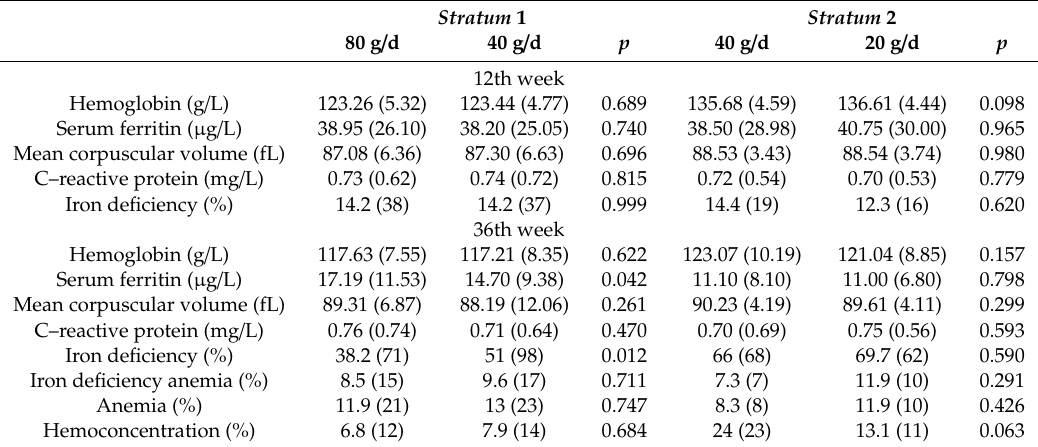
Table 2. Blood tests results of participants on week 36 of gestation according to supplementation dose.